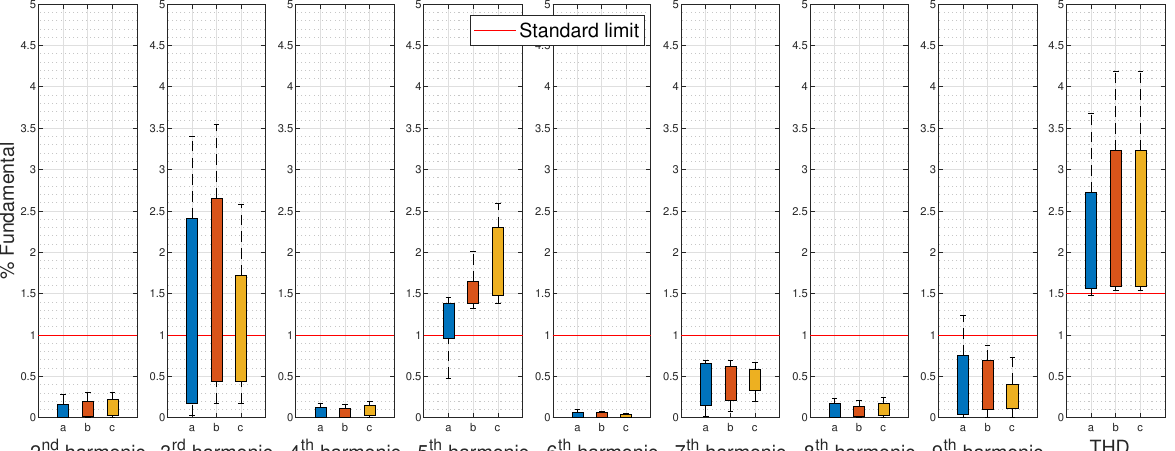
Figure 13. Voltage harmonics per phase at the bus_ca4 (farthest main bus). Table 2. Energy losses in the charging infrastructure. Total Energy Useful Energy Total Losses Consumption Consumption Case (kVAh) (kVAh) (kVAh) With Harmonics 2236 2049 187 Without Harmonics 2157 2049 108 Harmonic Losses 79 (42%) Table 3. Yearly energy losses in the charging infrastructure. Total Energy Useful Energy Total Losses Consumption Consumption Case (MVAh) (MVAh) (MVAh) 249 231 18 240 231 9 Harmonic Losses 9